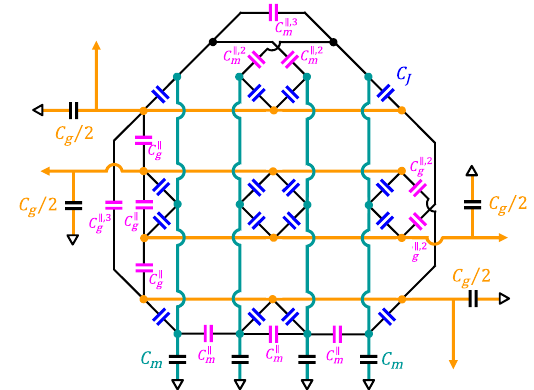
FIG. 8. Illustration of the capacitances present in a single site of the Josephson junction array. Orange thick lines are gauge wires, and green thick lines are matter wires. Black capacitors are the island self-capacitances C m and C g , blue are the junction bar- rier capacitances C J , and magenta are the parasitic capacitances between wires C || .